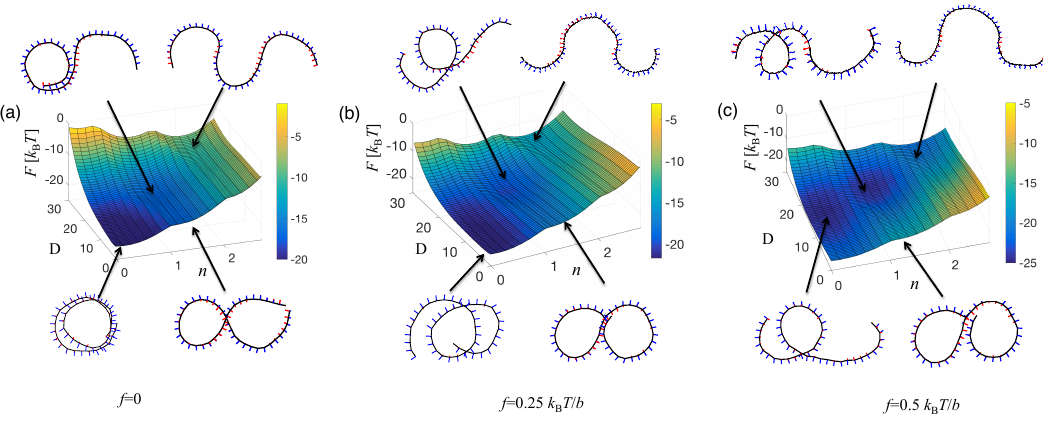
Figure 9. ( a ) Free energy landscapes without applied force ( f = 0) and ( b, c ) under increasing force ( f = 0.25 k B T / b , f = 0.50 k B T / b ). To fix the force scale: for b = 0.5 nm, given k B T ≈ 4 pNnm, k B T / b ≈ 8